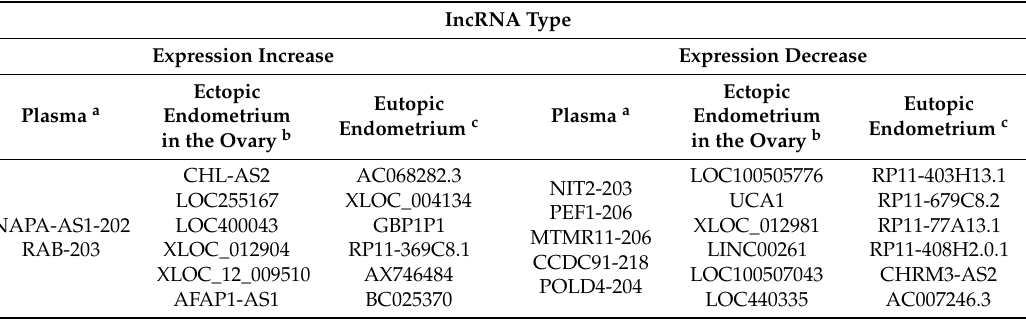
Table 2. Long noncoding RNA (lncRNA) expression disorders in